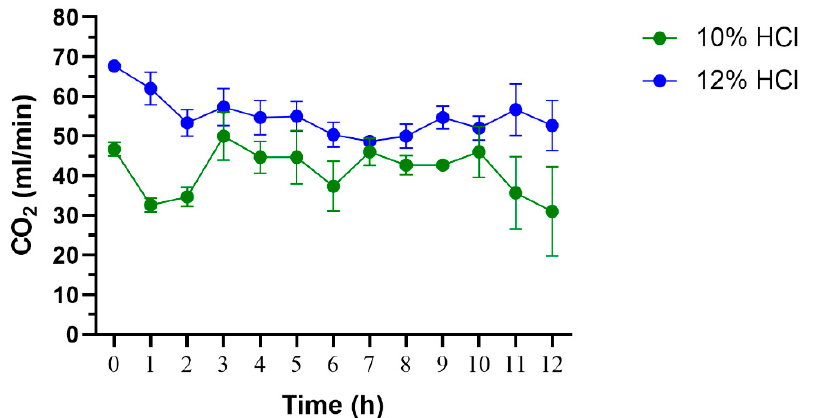
Figure 5. The amount of CO 2 produced from limestone and dripping acid solutions (30 drops/min) measured at one-hour intervals. Mean and standard error are